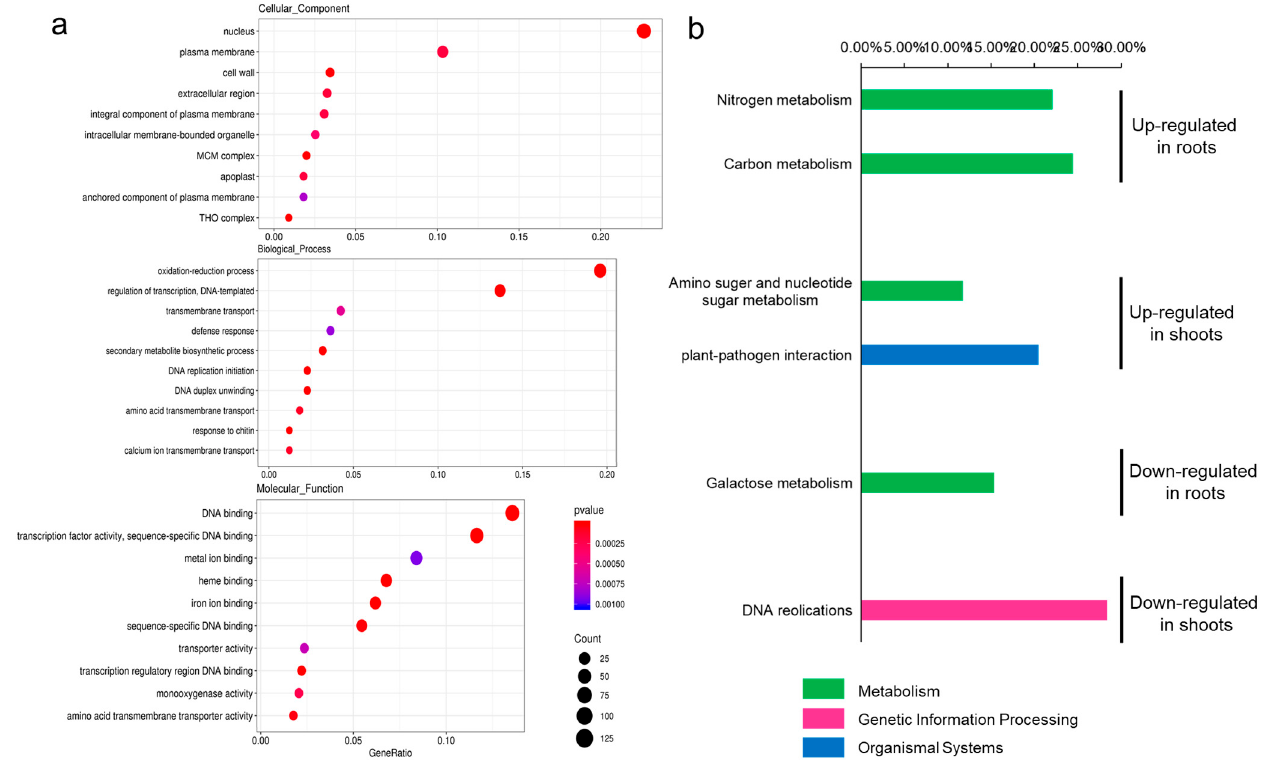
Figure 2. ( a ) GO and ( b ) KEGG analysis of the differentially expressed genes